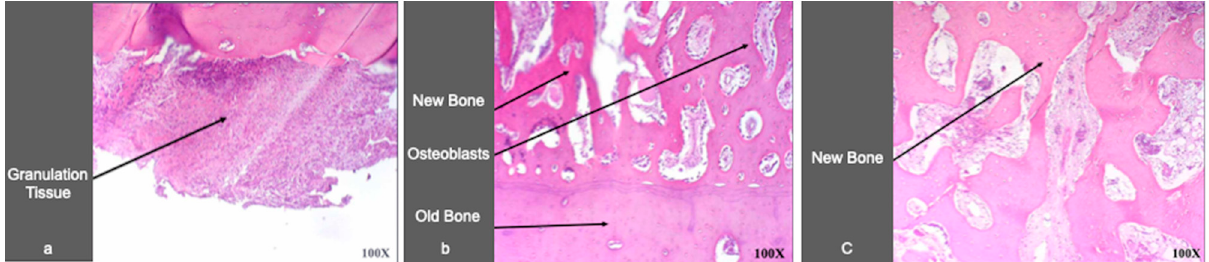
Figure 6. Examples of histological analysis in the presence of Fibronectin; 7 ( a ), 14 ( b ), and 56 ( c ) days (Hematoxylin and Eosin, 100X).